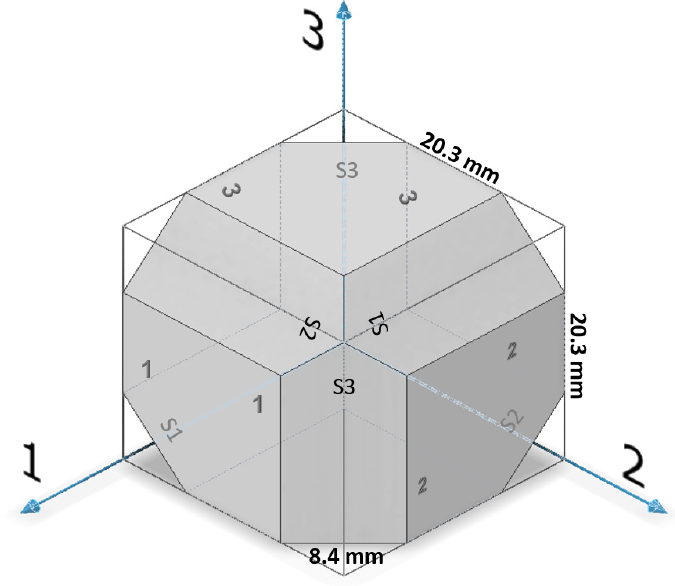
Figure 1. A polygon sample for the wrought and EBM Ti6Al4V alloys. Direction 3 is the rolling or build direction.